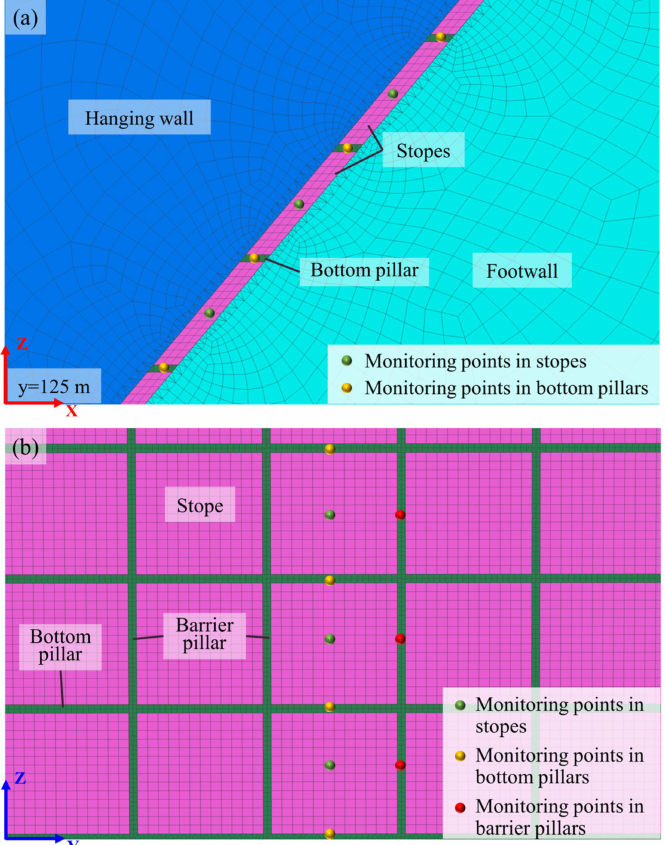
Figure 3. Schematic diagram of the location of stress monitoring points. ( a ) The view perpendicular to the Y axis; ( b ) The view perpendicular to the ore